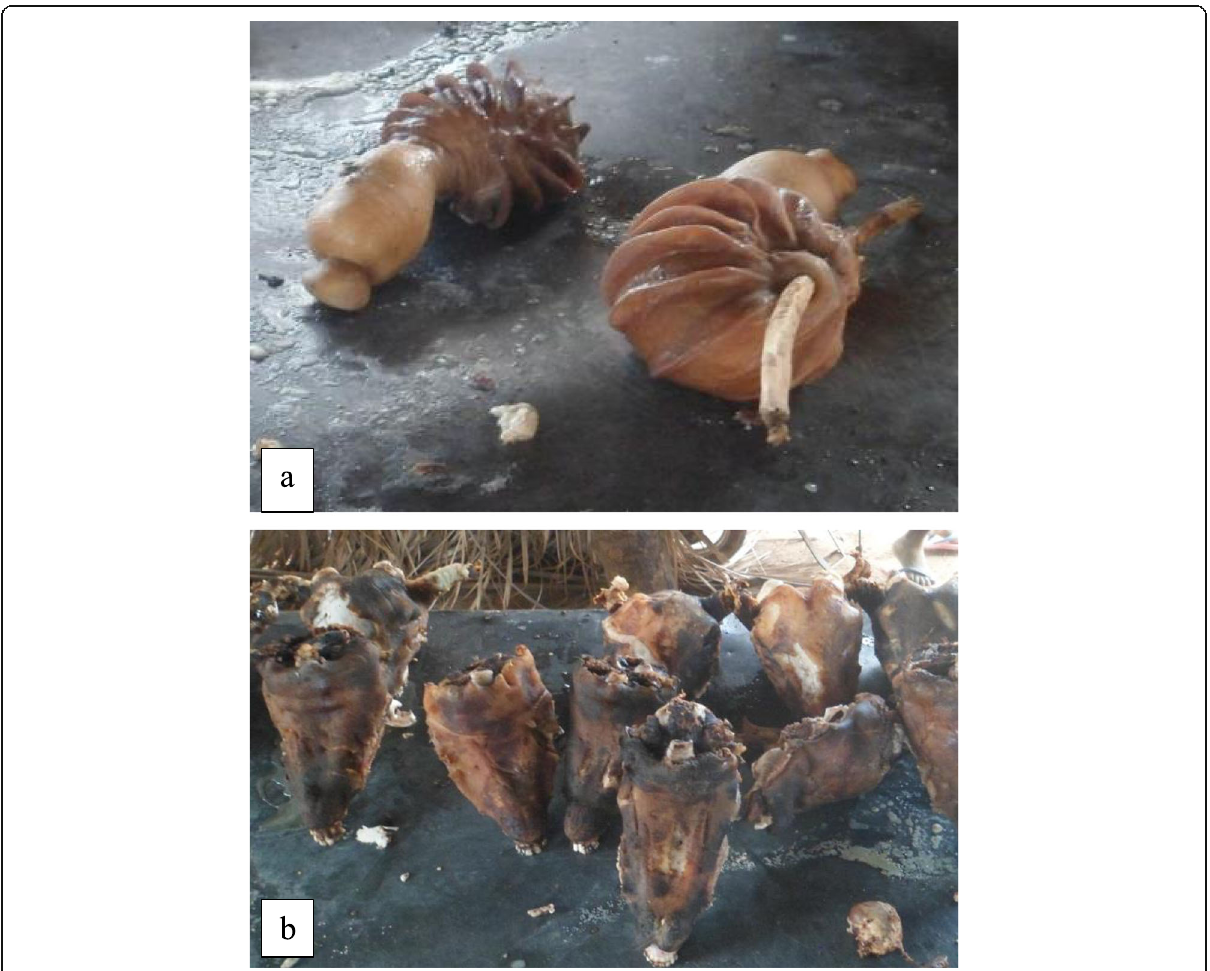
Fig. 4 Pictorial representations of common ethnic delicacies made using edible slaughter by-products. a A photo of Atienus , common among the Turkana community which is made using fatty tissue trimmings stuffed inside the colon and then boiled. b Scalded and then boiled goat heads, photo taken in Kajiado